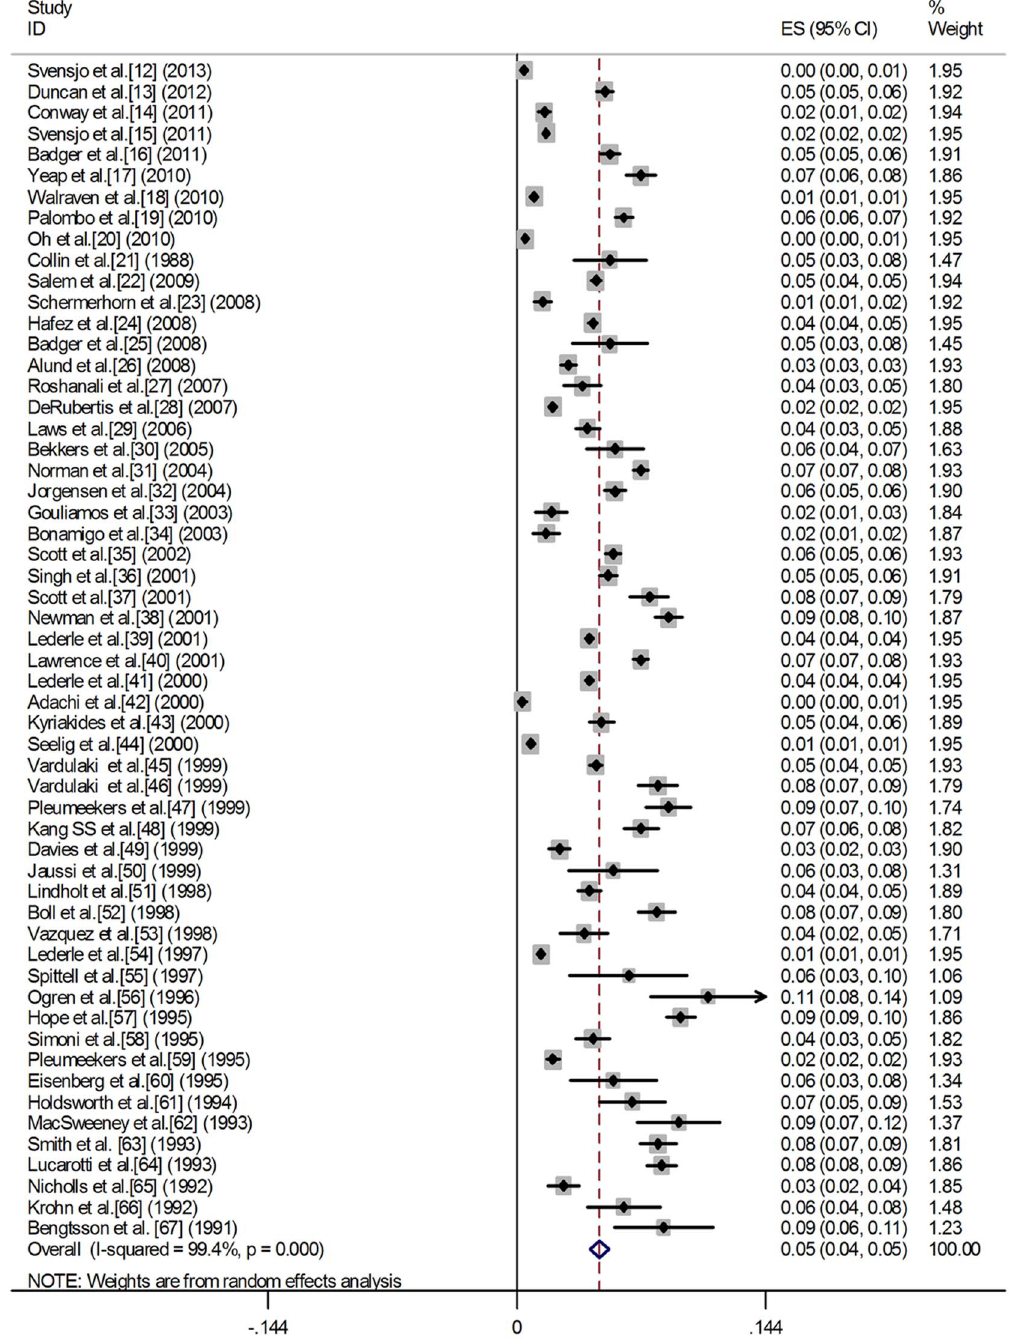
Figure 2. A forest plot of prevalence from individual studies and combined prevalence from random-effects models.